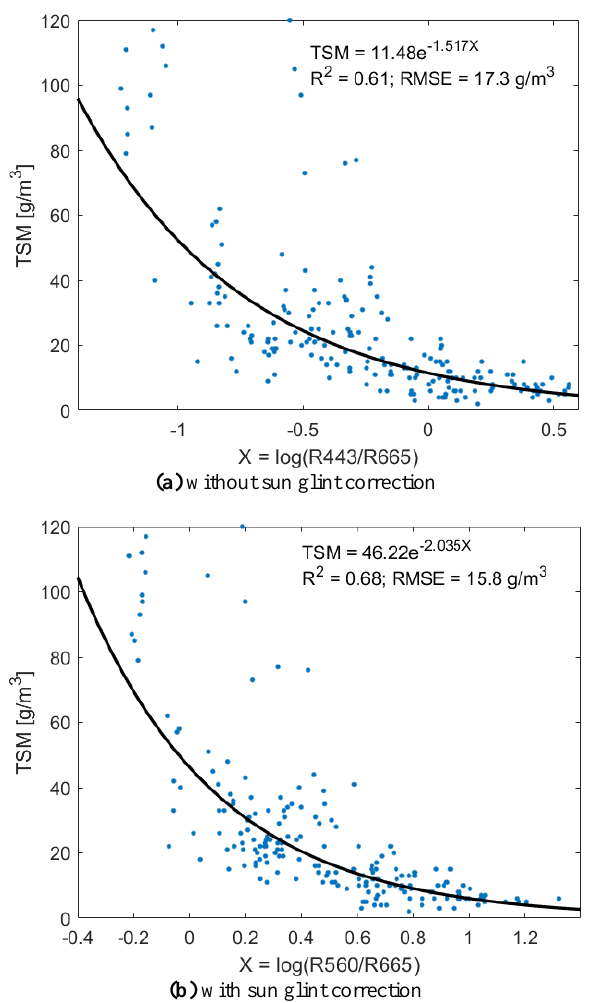
Figure 4 . Exponential models for TSM estimation derived from OBRA (a) without and (b) with sun glint correction.